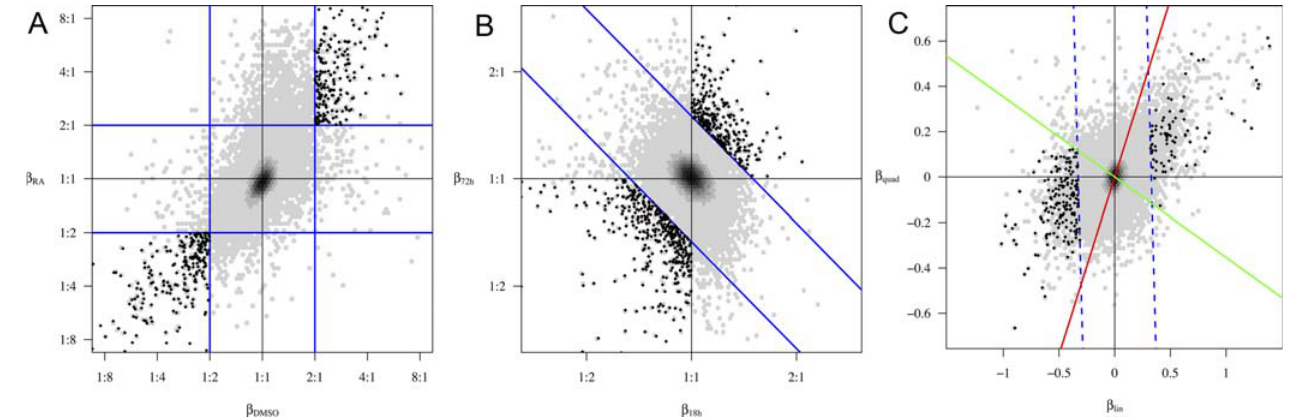
Figure 2. Transcriptome Plots of Estimated Expression Changes, Based on Fitting Models to Each Dataset All plots have density shading to demonstrate the number of points (genes) in different regions. Lines illustrate examples of some of the requirements that make up the definition of the ESC signature change and observed gene expression patterns that fulfilled all requirements are marked as ¤ . Experiment-specific implementations of requirements are explained below. (A) DMSO/RA dataset. The requirement for large absolute changes is illustrated by the solid blue lines. Consistency across conditions implied that genes must exhibit a change in the same direction in both treatments (bottom left or top right quadrant). (B) R1–LR dataset. Note that the y -axis is the change seen at 72 h relative to that seen at 18 h. The requirement for large absolute changes is illustrated by the solid blue lines. The criterion for consistency was applied by requiring that the change 18 h after LIF removal be in the same direction as that after 72 h (i.e., in the lower left or upper right quadrants), regardless of its magnitude (C) M–LR dataset. The requirement for large absolute changes is illustrated by the dashed blue lines. To meet the consistency criterion, we required that a temporal gene expression trend either increase or decrease continuously over the duration of the experiment. This requirement was relaxed slightly to retain trends with a direction change occurring either very early (red line) or very late (green line).